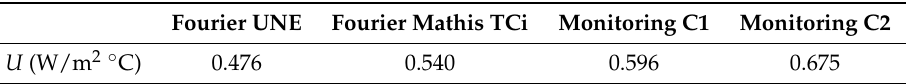
Figure 14. Dynamic temperature graphs by hours for 24 February 2013. ( Left ) Data obtained by monitoring; ( Right ) gradients in steady state according to Fourier.